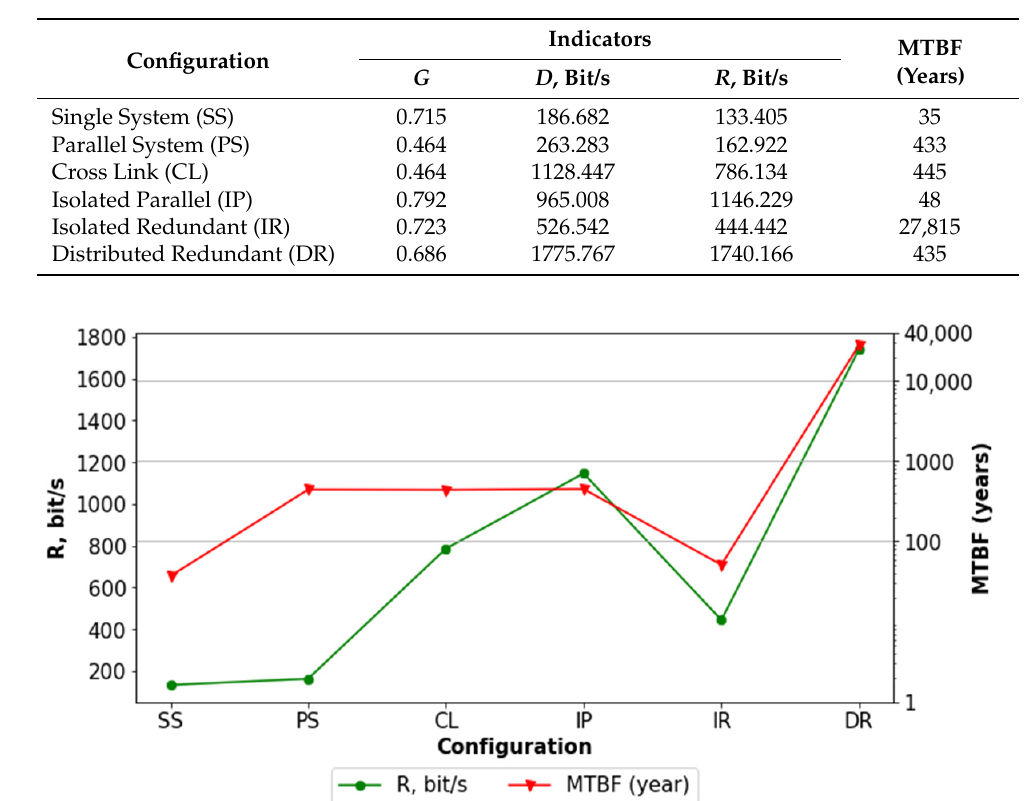
Figure 10. Comparison of R and MTBF for the configuration of special PSSs. Table 4. Information indicators of PSS’s